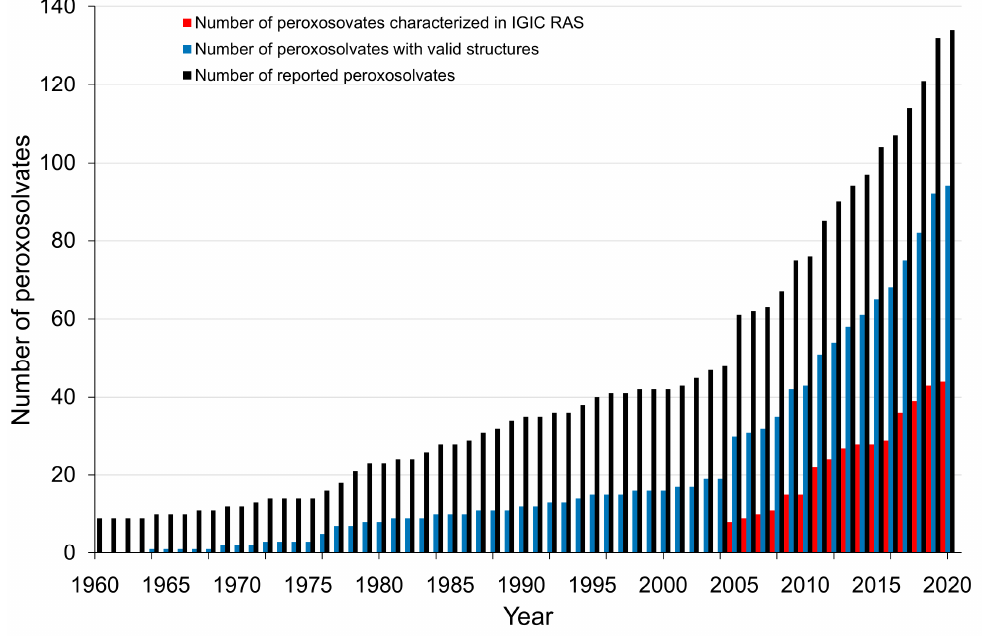
Figure 1. Cumulative chart of the total number of peroxosolvates in the period 1960–2020.